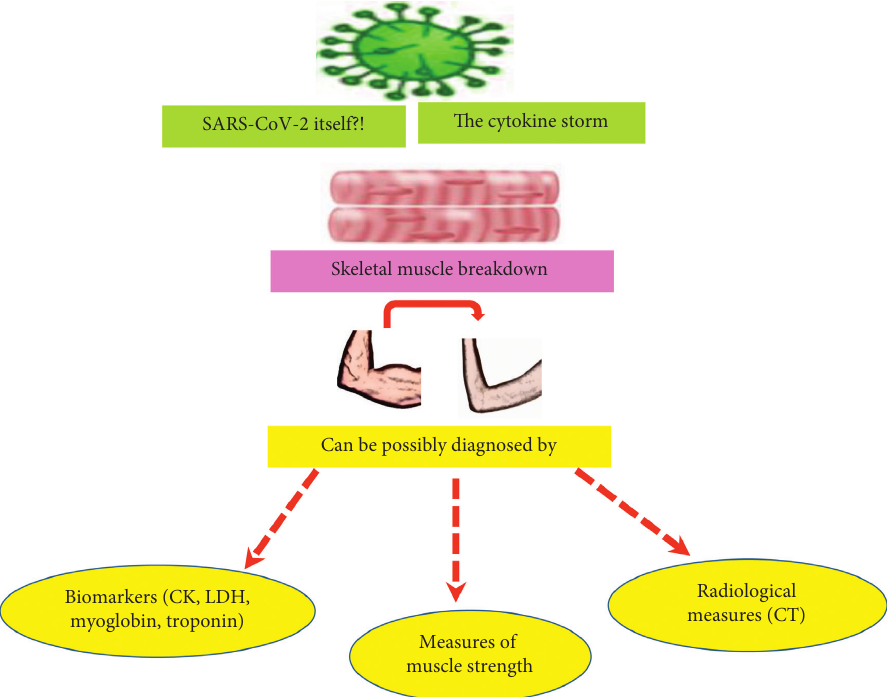
Figure 2: Possible approaches to detect muscle injury in symptomatic COVID-19 patients. Abbreviations: SARS-CoV-2: severe acute respiratory syndrome coronavirus-2, CK: creatine kinase, LDH: lactate dehydrogenase, CT: computed